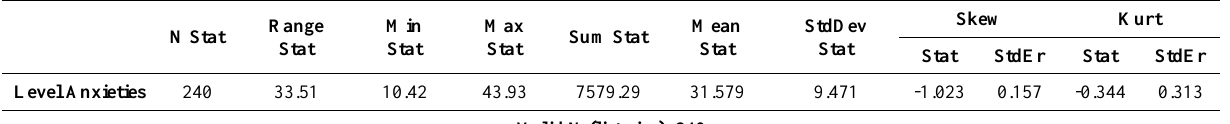
Table 3. Description of WBP Anxiety Variables